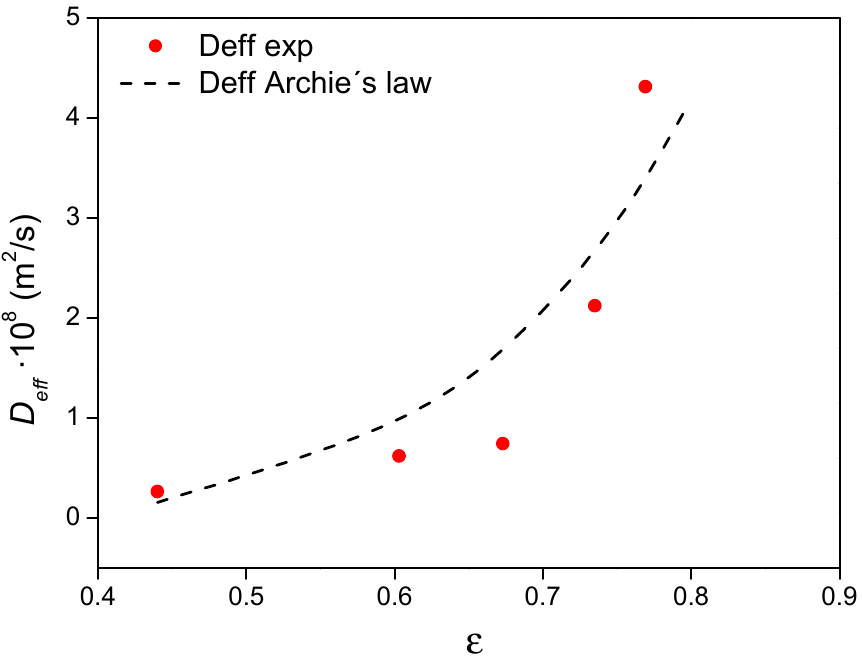
Figure 10. Diffusion coefficients (D eff ) as a function of ε and their comparison to those obtained based on Archie´s law.